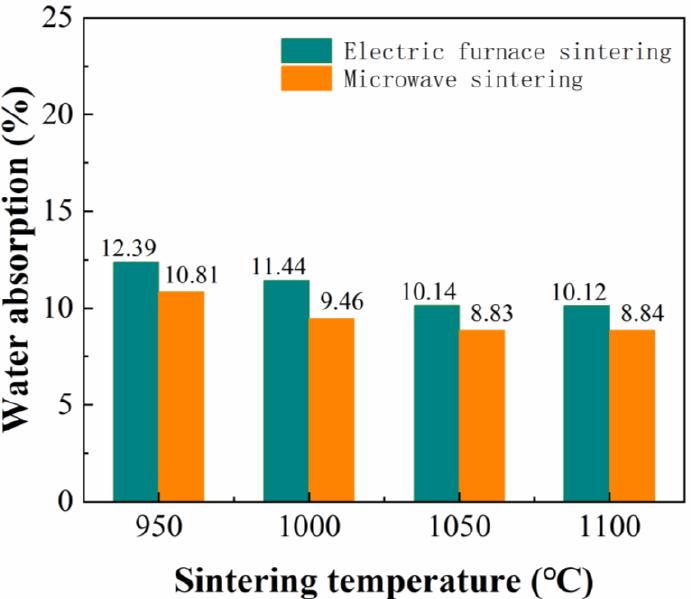
Figure 13. Influence of heating rate and holding time on water absorption of MGS sintered brick. ( a ) The effect law of heating rate on porosity. ( b ) The effect of holding time on water absorption rate law.